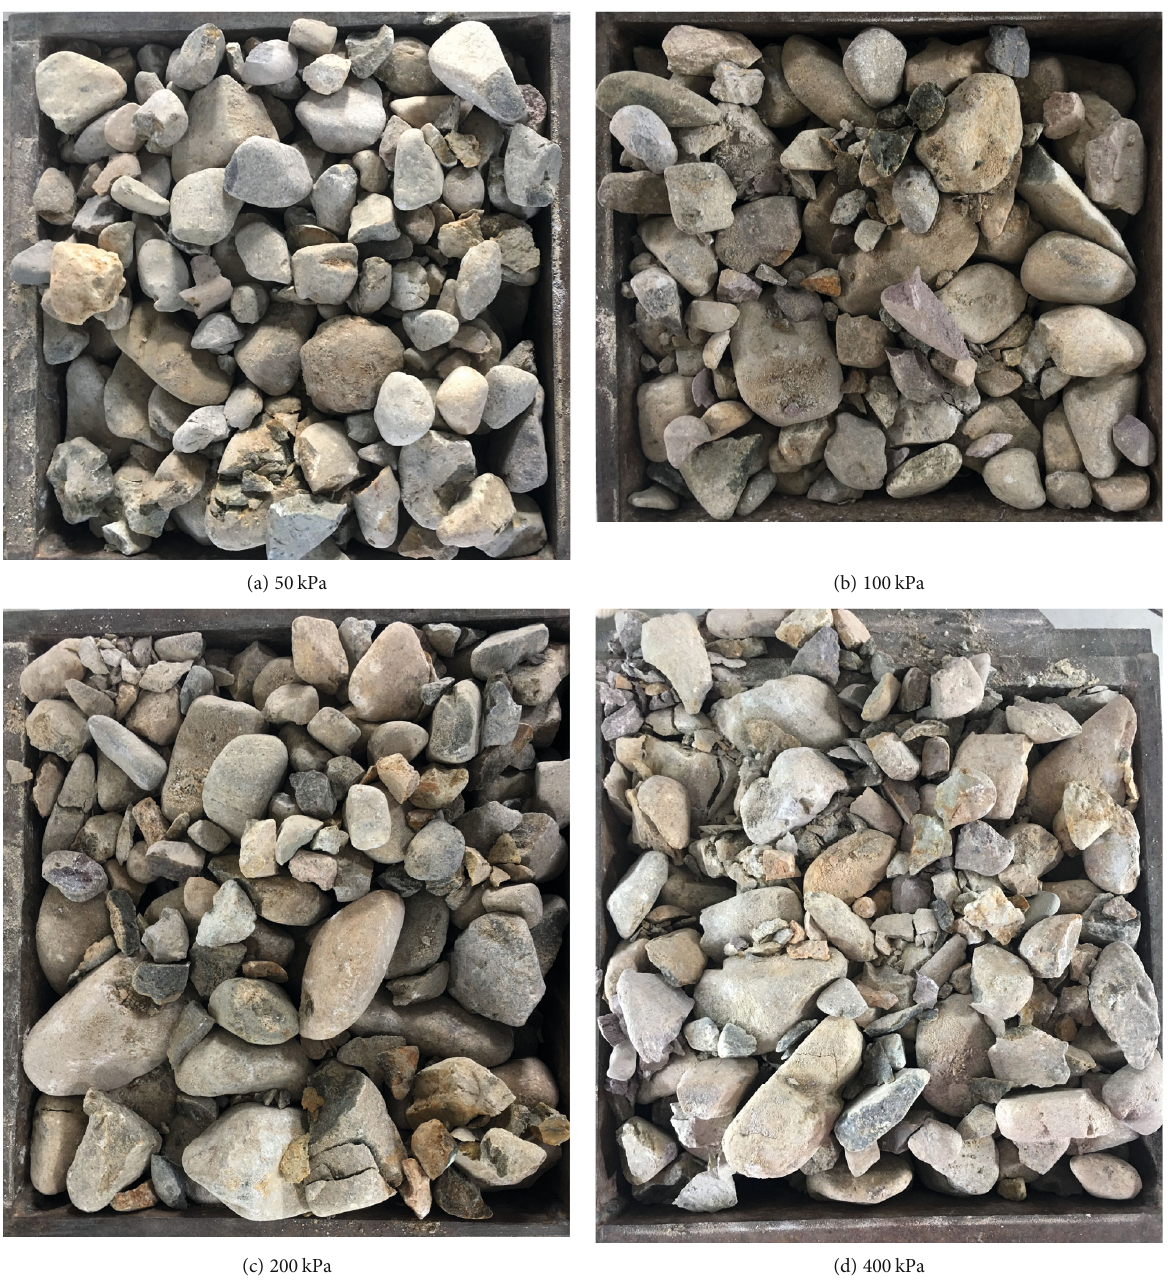
Figure 8: Shear plane of sample I-1 under di ff erent normal